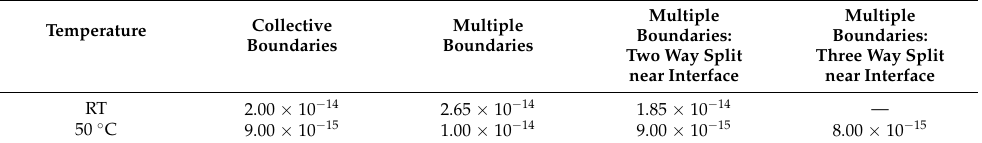
Table 2. Diffusion coefficients (cm 2 /s).